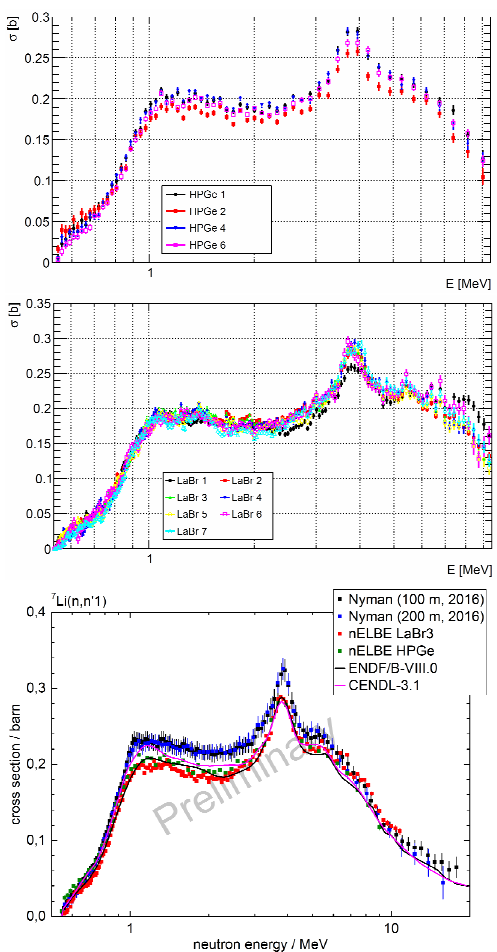
Figure 7. Preliminary photon production cross section for the 7 Li 478 keV γ -ray determined by each single HPGe (top) and LaBr 3 (middle) detector. The bottom graph compares measured mean values from the present work with previous measurements [2] and